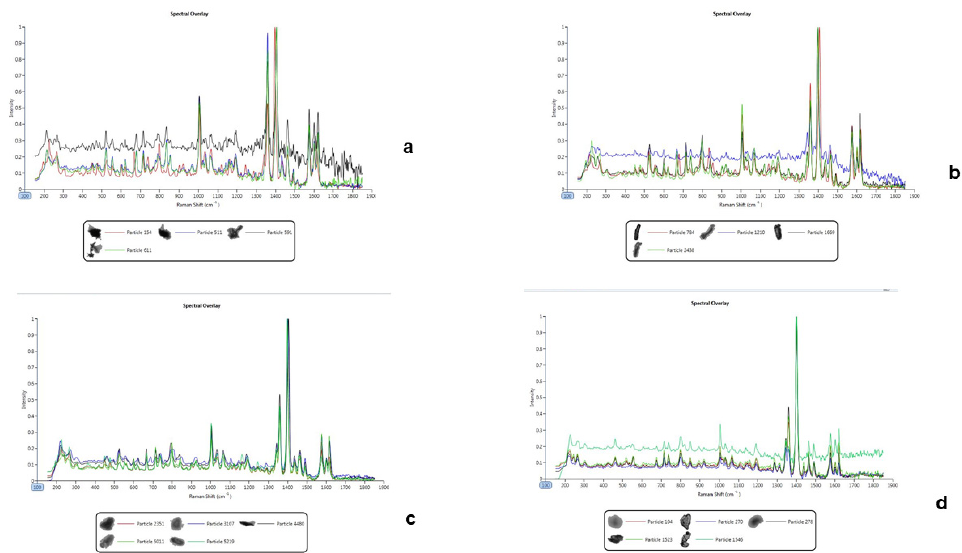
Figure 4. Raman spectra of the free base (uppermost spectra in each overlay) superimposed on the spectra generated by particles of the bedaquiline salts. Therefore, the Raman spectra from the salts could not be differentiated from the free base fingerprint. ( a ) Benzoate salt, ( b ) free base, ( c ) HCl salt, ( d ) malonate salt.